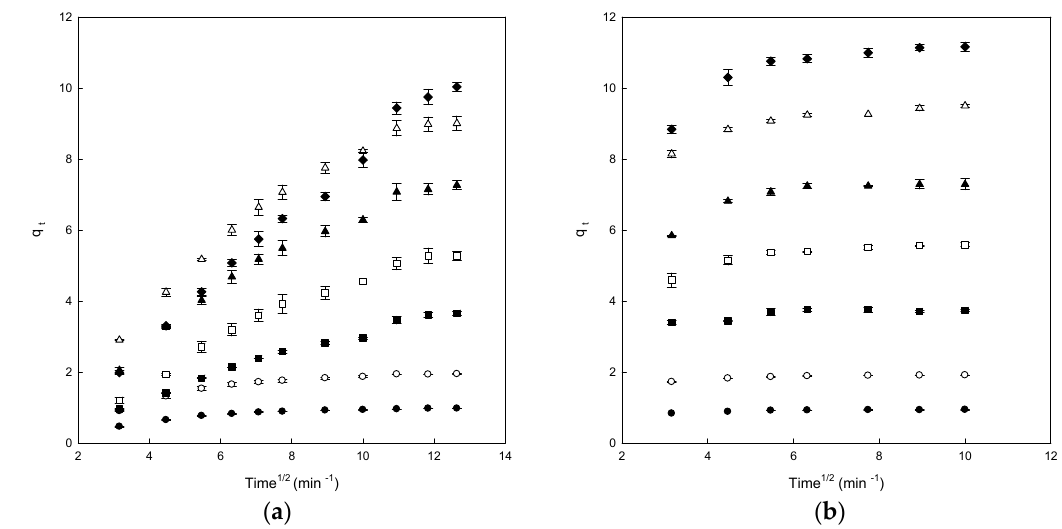
Figure 5. The intraparticle diffusion model plots for the Direct Blue 78 adsorption onto chitosan-NaOH ( a ) and β -CDs-EPI ( b ) polymers at di ff erent dye concentrations (25 mg/L ( ● ), 50 mg/L ( ○ ), 100 mg/L ( ■ ), 150 mg/L ( □ ), 200 mg/L ( ▲ ), 250 mg/L ( Δ ) and 300 mg/L ( ♦ )).